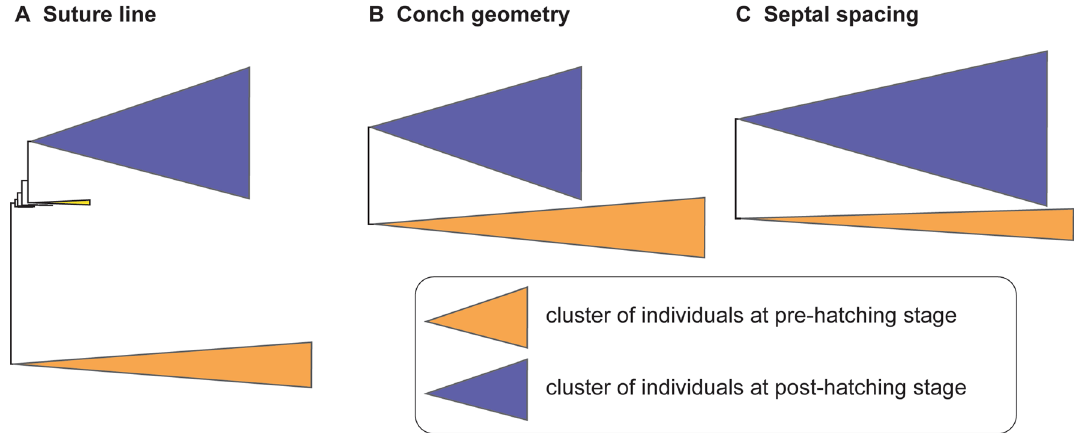
Figure 3. Simplified tree topologies for ( A ) the morphology of suture line, ( B ) conch geometry, and ( C ) septal spacing. The areas colored in orange and blue indicate the clusters at pre-hatching and post-hatching,